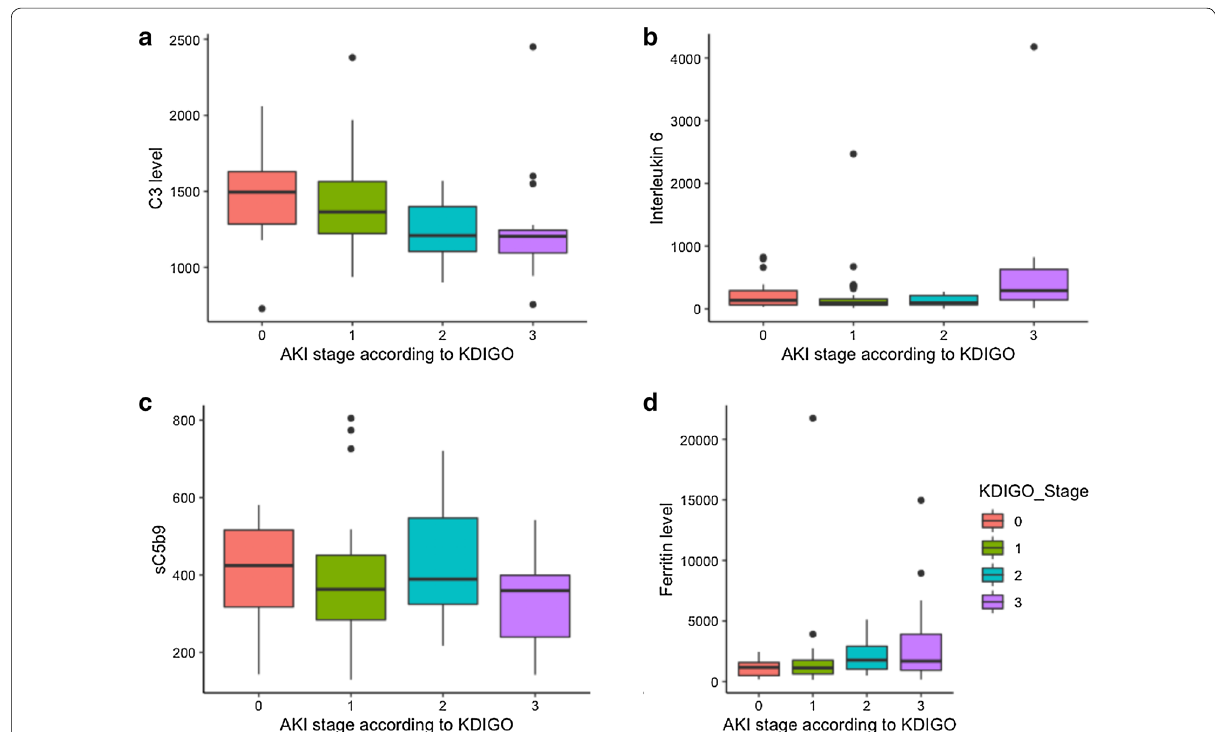
Fig. 1 Boxplots depicting relationship between AKI severity and C3 [ng/mL] ( p and ferritin levels [mg/L] ( p